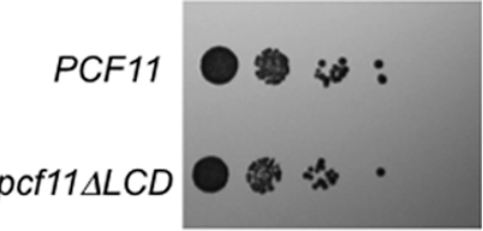
Fig 5. Pcf11 ’ s LCD is not essential for viability. Yeast bearing a LEU2 -marked plasmid with wildtype PCF11 or PCF11 from which the region encoding its LCD was deleted ( pcf11 Δ LCD ), were grown in liquid media, serially diluted, spotted onto solid media, and grown at